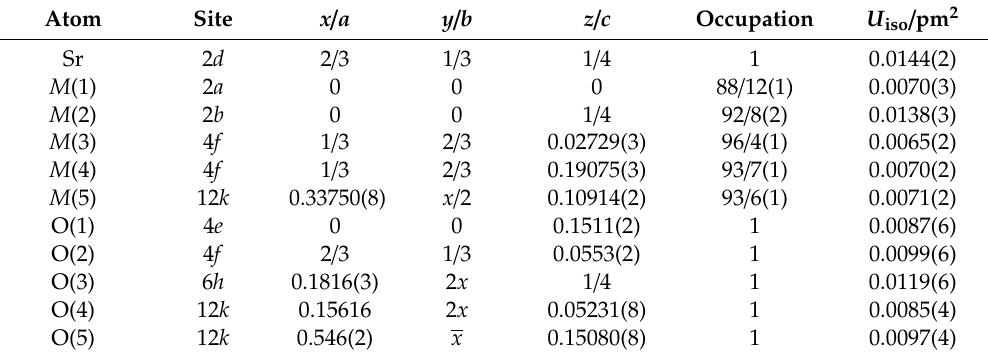
Table 2. Wycko ff sites, fractional coordinates in the asymmetric unit, occupational parameters and isotropic displacement factors for every unique ion site of the pristine crystal 1 (SrFe 11.2(1) Al 0.8(1) O 19 ) with M = Fe, Al (composition from single crystal X-ray di ff raction (scXRD) refinement).